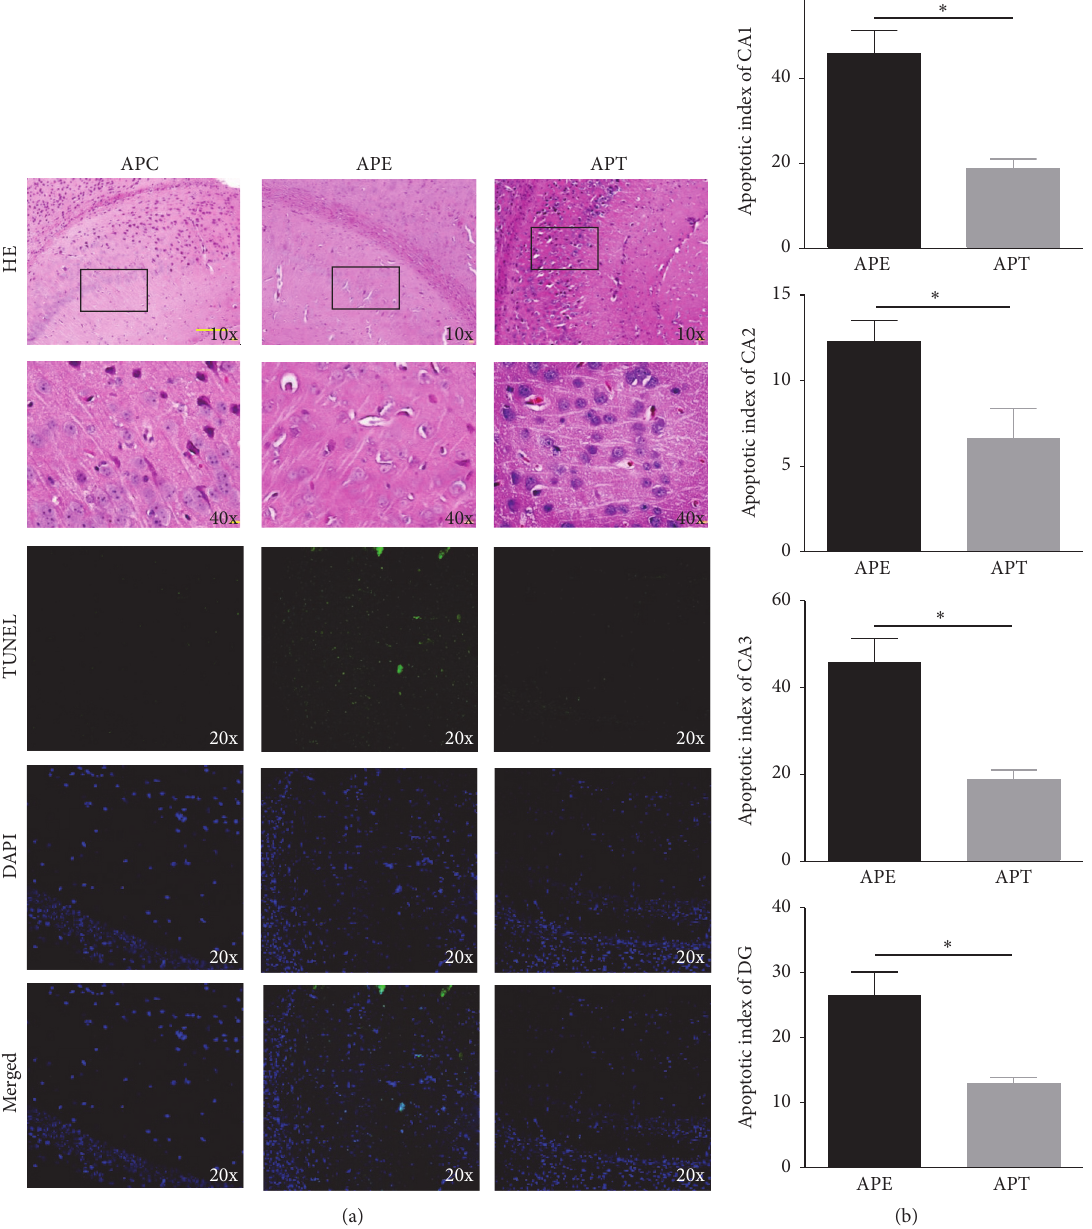
Figure5:ProtectiveeffectsofmiR-146amimicsonthehippocampus2 hafterpilocarpineadministration.(a)RepresentativeHE-stainedslices showed that the hippocampal nuclei (blue) almost disappeared in the APE group but were markedly stained in the APT group; representative TUNEL- and DAPI-stained slices showed all hippocampal cells (DAPI in blue) and significant apoptosis of hippocampal cells (TUNEL in green, merged TUNEL and DAPI in cyan) in the APE group, but no visible apoptosis was observed in the APT group. (b) To prevent manual mistakes, the apoptotic indices were calculated using Image-Pro plus 6.0 (Media Cybernetics, Bethesda, USA), which were consistently lower in all regions of the hippocampus (CA1, CA2, CA3, and DG) of the APT group than the APE group. ∗ 𝑝 < 0.05